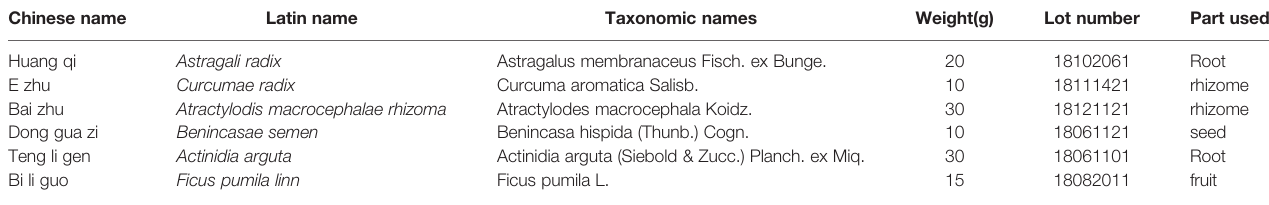
TABLE 1 | The compositions of Astragalus Atractylodes mixture